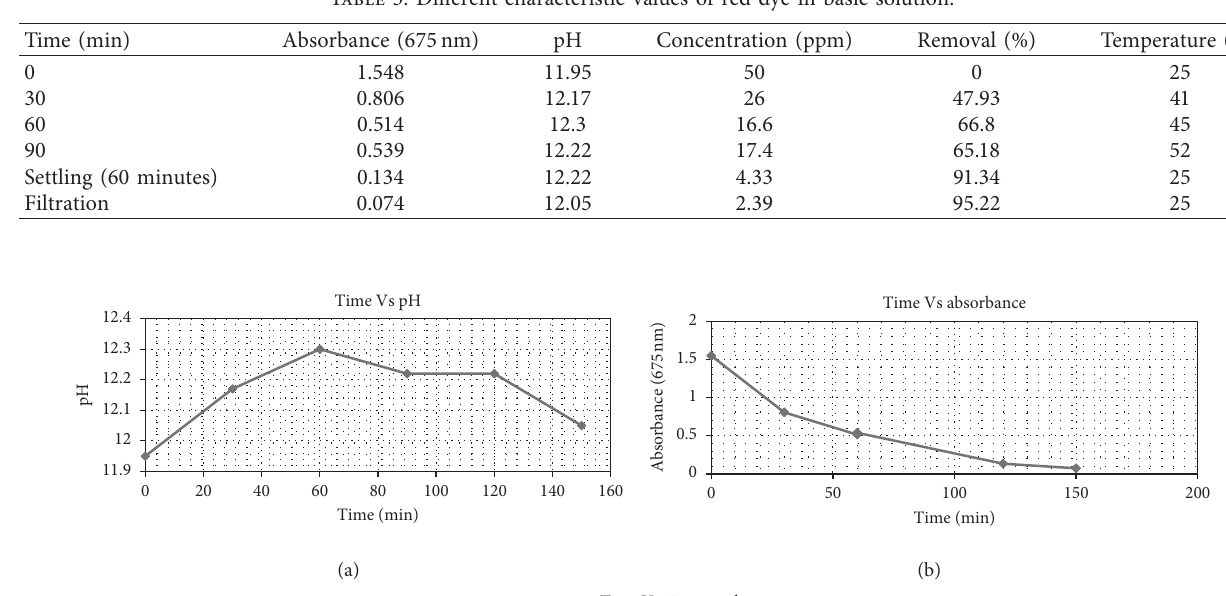
Figure 5: (a) Plot of pH with respect to time over 200min period. (b) Plot of absorbance with respect to time over 200min period. (c) Plot of percent removal with respect to time over 160min period. Table 3: Different characteristic values of red dye in basic solution.